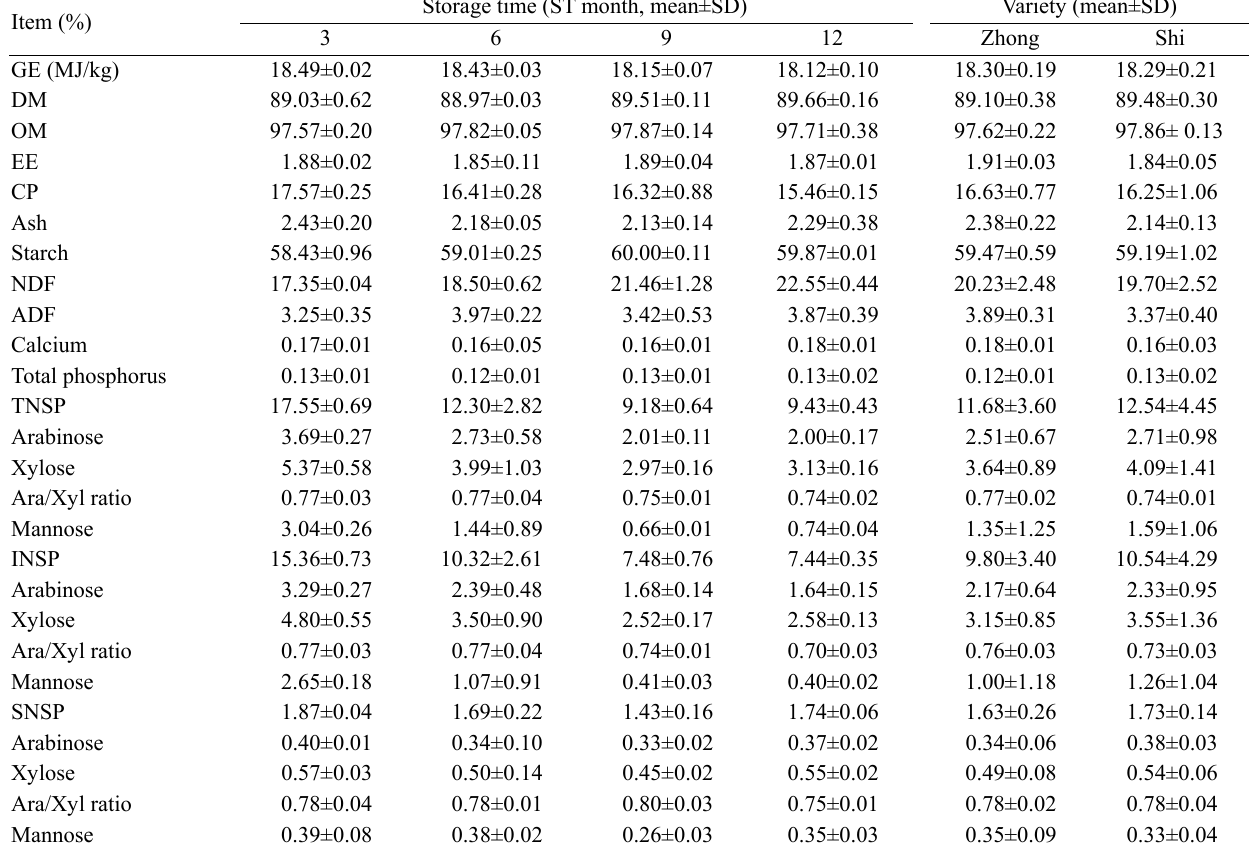
Table 3. Effects of storage duration on the chemical composition and energy content of wheat (DM